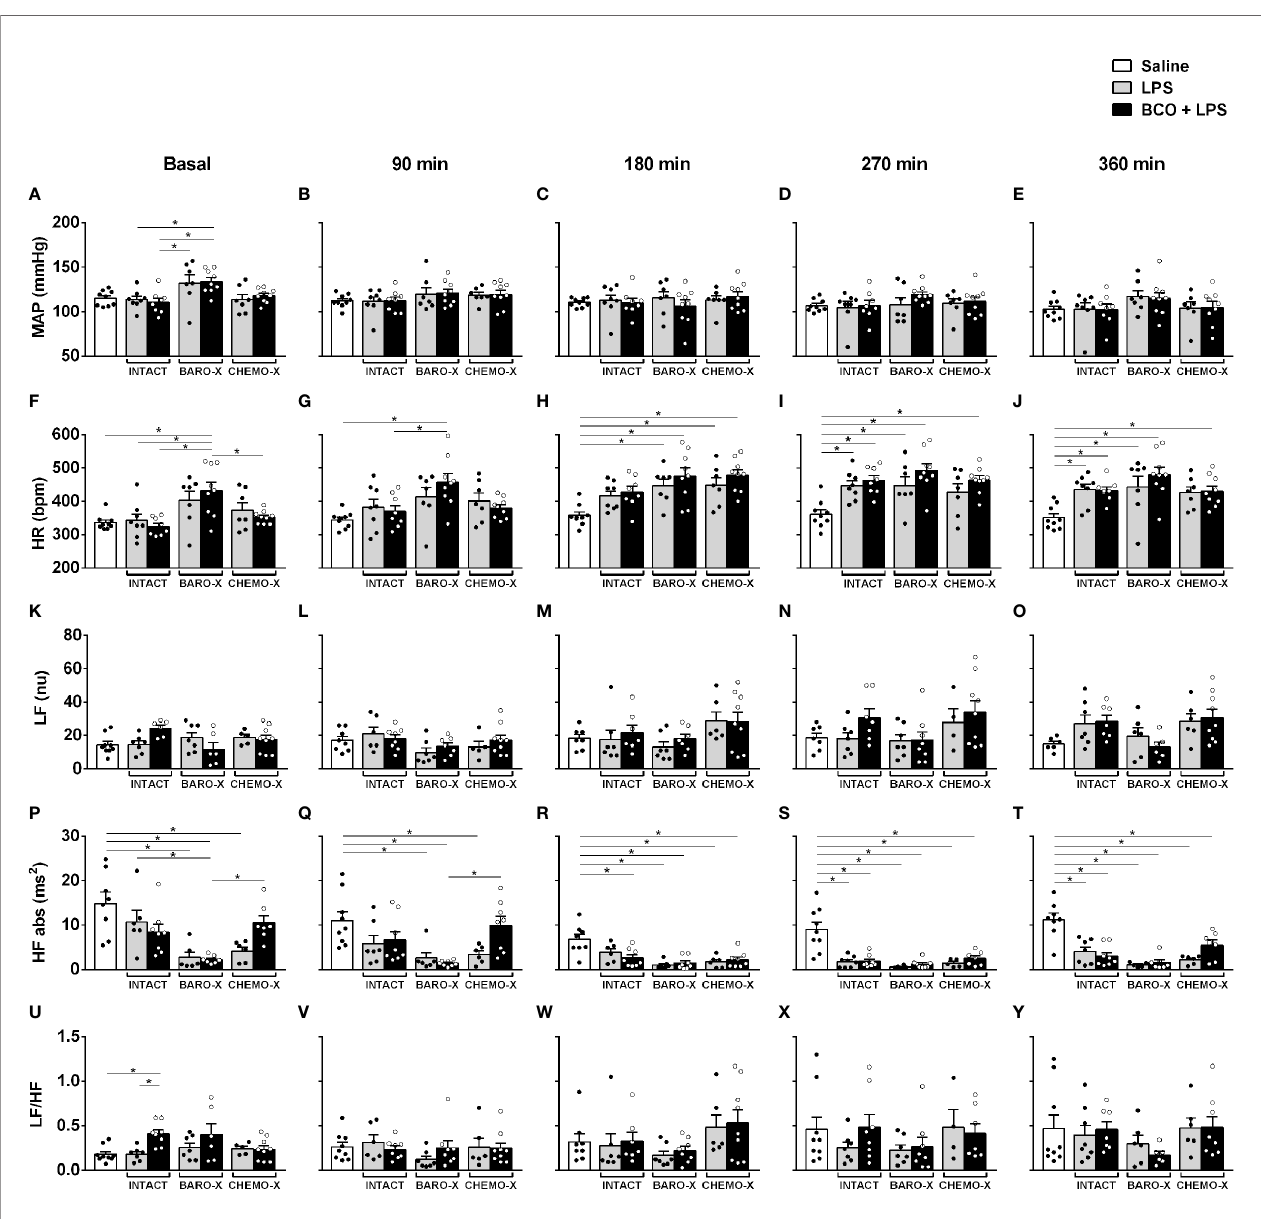
FIGURE 2 | Time course of hemodynamic and cardiac interval variability responses. Mean arterial pressure (MAP; panels A – E ), heart rate (HR; panels F – J ), low-frequency band (LF; panels K – O ), and high-frequency band (HF; panels P – T ) in the spectrum of the cardiac interval, and LF/HF ratio (panels U – Y ) at different times: baseline, 90, 180, 270, and 360 min after LPS or saline. BARO-X, selective denervation of baroreceptors; BCO, bilateral carotid occlusion; CHEMO-X, selective denervation of chemoreceptors; LPS, lipopolysaccharide. Bars represent mean ± SEM. *p <